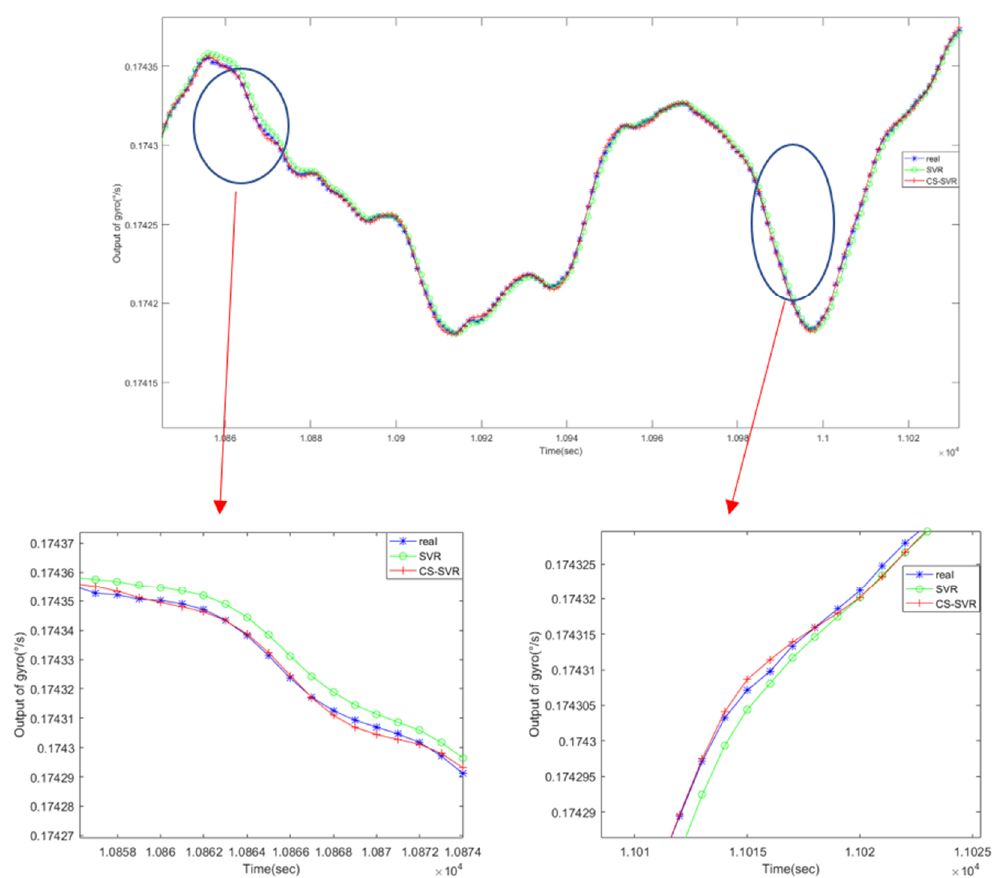
Figure 16. Comparison of the prediction results between SVR and CS-SVR.